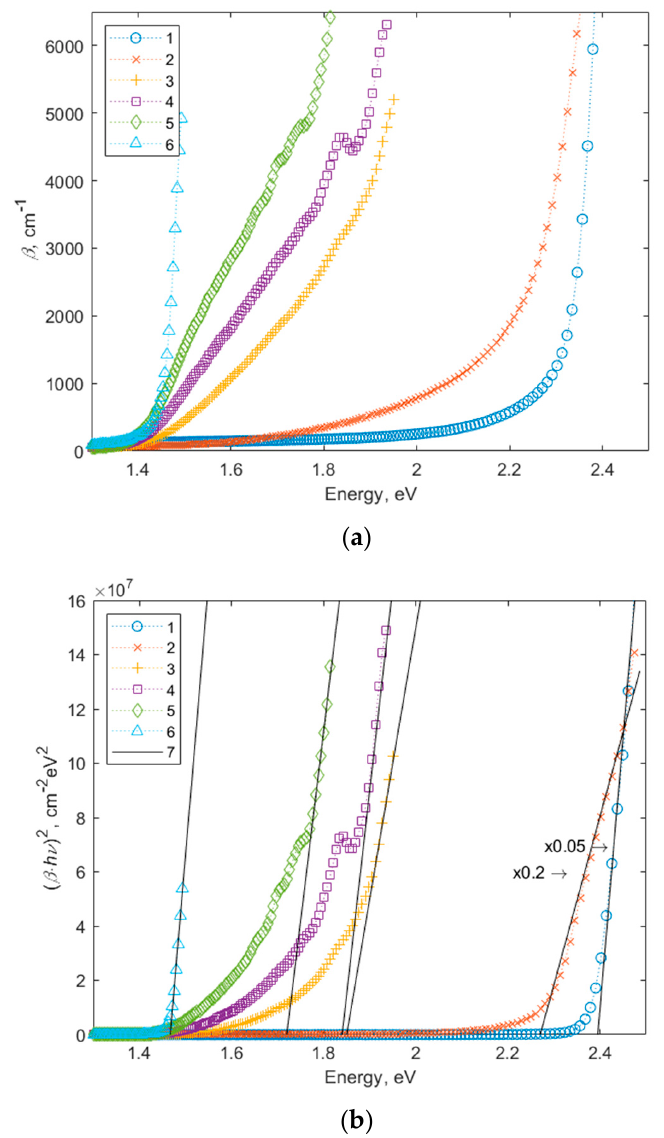
Figure 5. ( a ) Optical absorption coefficient spectra of CdS 1 − x Te x samples computed with Equation (4), R = 0.25. ( b ) Tauc’s characteristics. 1: x = 0; 2: x = 0.016; 3: x = 0.05; 4: x = 0.07; 5: x = 0.1; 6: x = 1; 7: